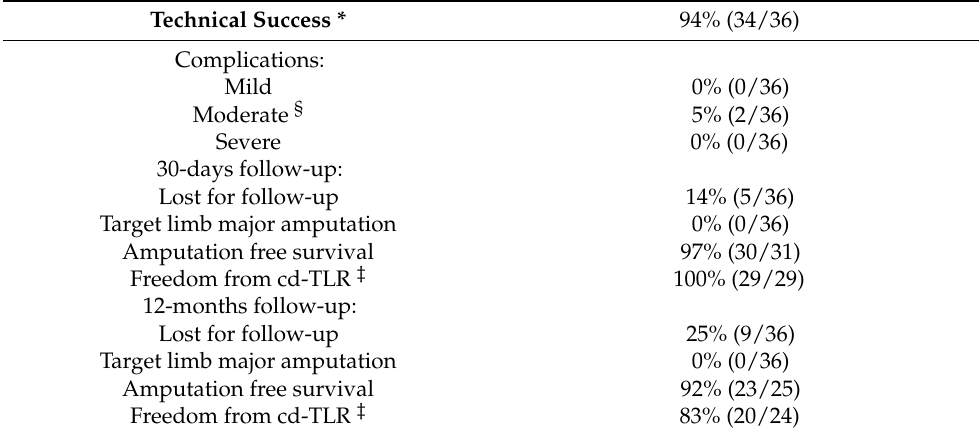
Table 3. Main study outcomes (n =